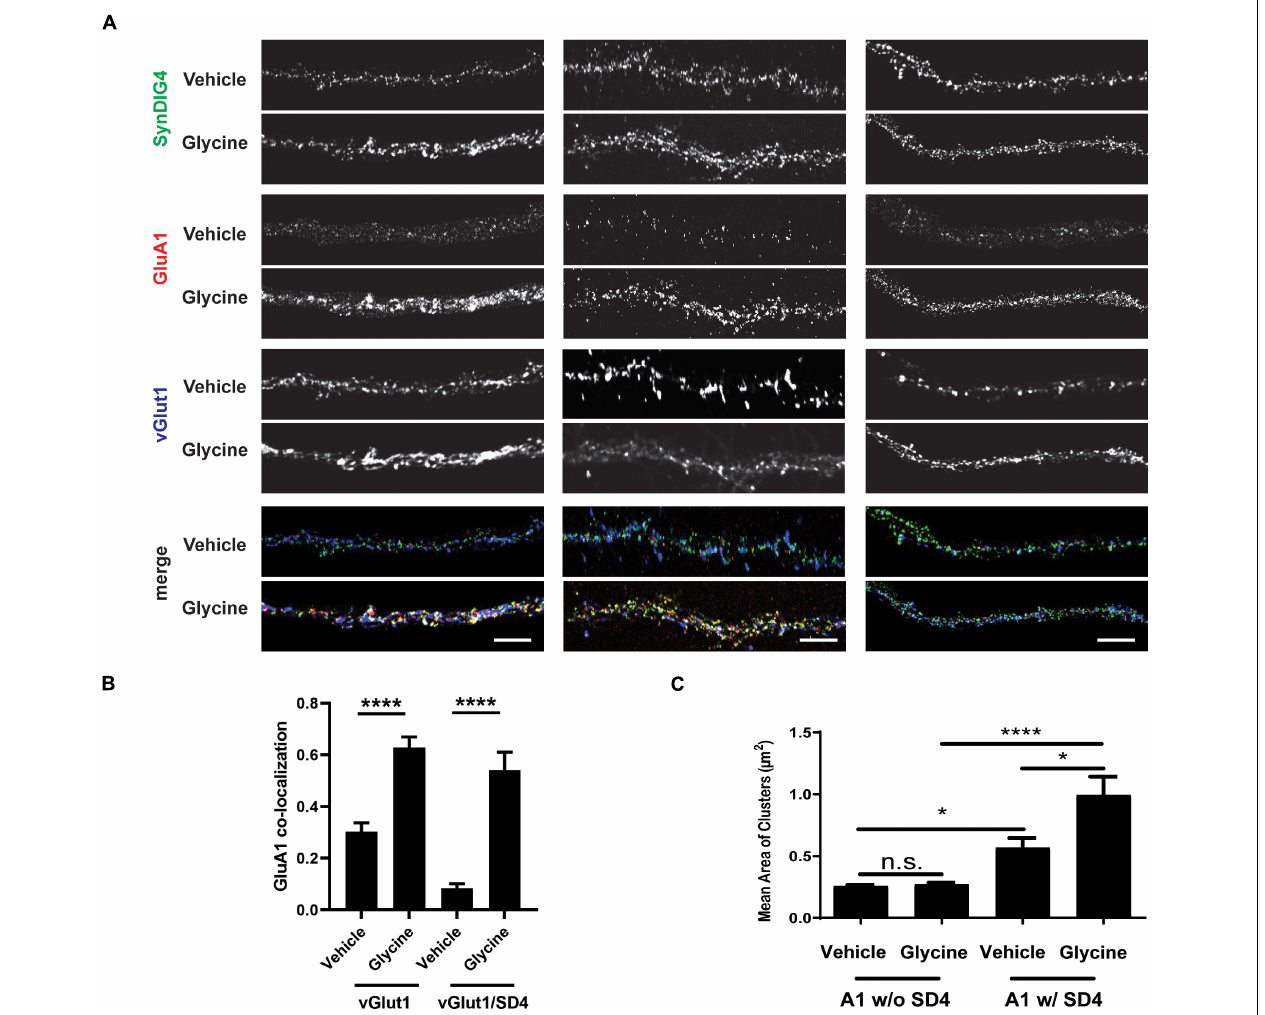
FIGURE 8 | Co-localization of SD4 with synaptic GluA1 is increased after chemical-LTP. (A) Representative confocal images of dendritic stretches from primary rat hippocampal neurons at DIV13. Three dendritic stretches are shown for each condition. Neurons were treated with either vehicle or 200 µ M glycine in artificial cerebrospinal fluid (aCSF) without magnesium at 37 ◦ C for 5 min. Neurons were transferred to aCSF recovery buffer (without drugs) for 20 min and then stained with anti-GluA1 antibody at 37 ◦ C for 1 h. Neurons were then fixed, permeabilized, and stained for total SD4 and vGlut1. (B) Quantification of co-localization between GluA1, SD4, and vGlut1 upon incubation with vehicle or glycine. (C) Quantification of mean area of GluA1 clusters either co-localized or non-colocalized with SD4 after treatment with vehicle or glycine. Data represented as mean ± SEM; n.s., non-significant; n = 15 cells per condition; * p < 0.05; **** p < 0.0001;